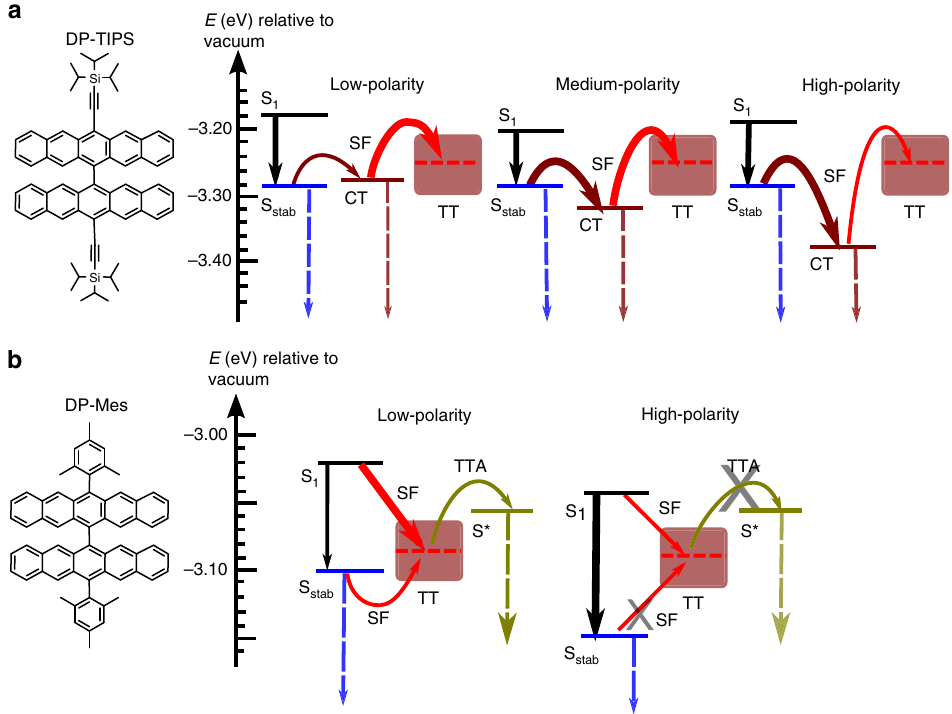
Figure 9 | Summary of solvent-dependent SF in orthogonal pentacene dimers. ( a ) In DP-TIPS, rapid initial solvent stabilisation of S 1 is followed by CT state formation. The CTstate is intermediate to TT formation, and its energy can be tuned with solvent polarity. At very high polarities CT functions as an energetic trap, severely reducing the triplet yield. No radiative TTA is observed in DP-TIPS. ( b ) In DP-Mes, direct SF competes with solvent relaxation into S stab . In non-polar media, solvent stabilisation is weak and all singlet states are able to undergo SF, while subsequent TTA forms a planarized and emissive singlet state S*. In high-polarity media, solvent stabilisation results in long-lived and lower-energy S stab states, and no radiative TTA occurs. Dashed arrows indicate radiative transitions, and solid arrows denote efficient (thick) and inefficient (thin) excited-state conversions. Energies are taken from absorption (S 1 ), fluorescence (S stab , CT and S*) and phosphorescence (Supplementary Fig. 27, TT B 2 (cid:3) T 1